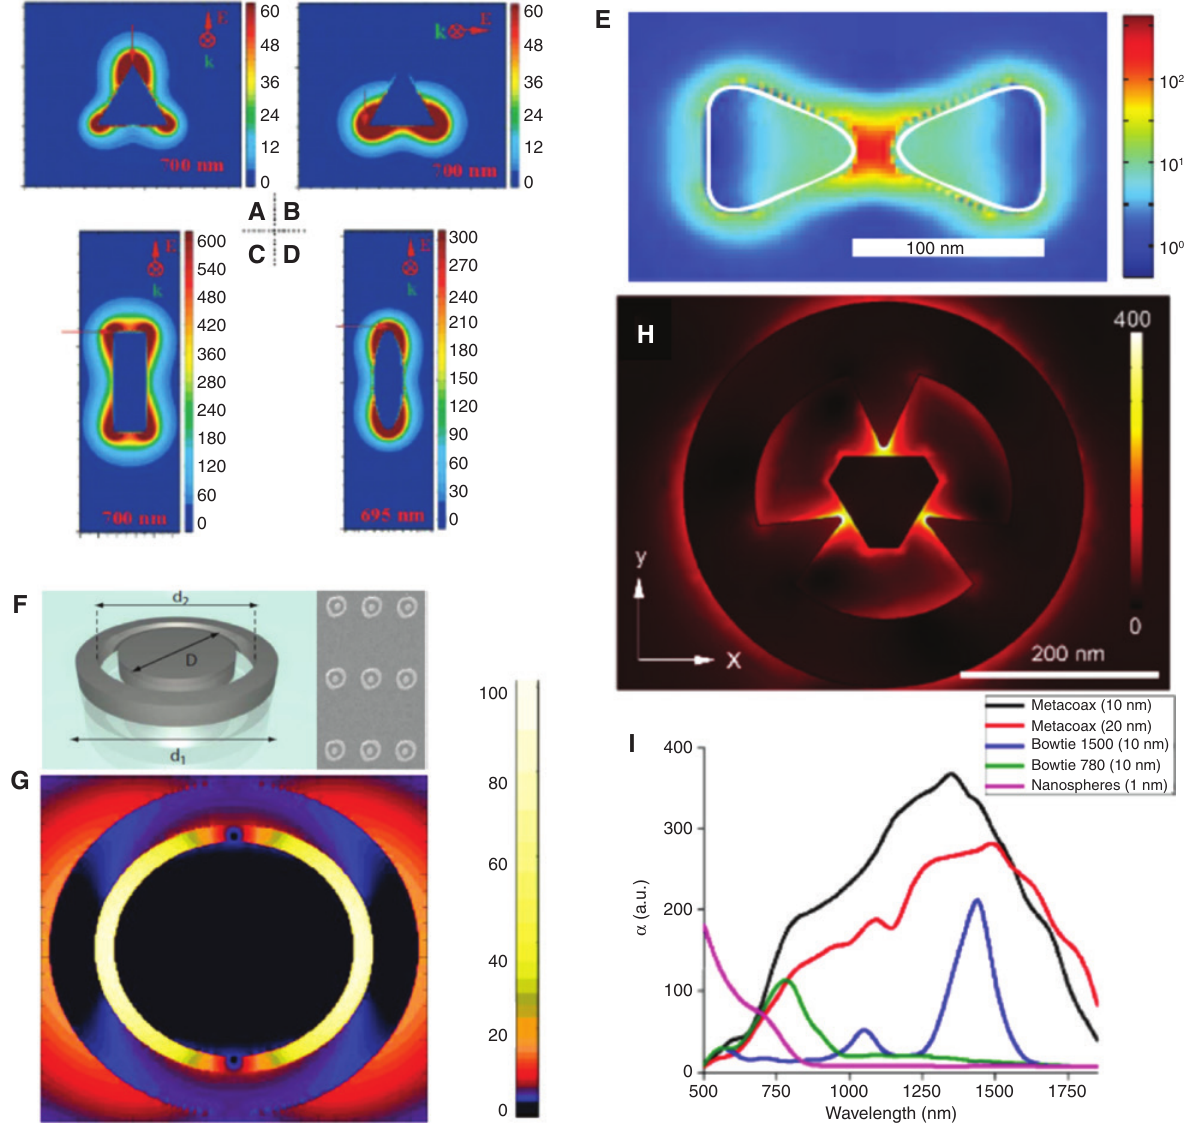
Figure 11: Selection of field intensity distribution calculations for different types of NPs and NP arrangements. (A) and (B) triangles excited at different orthogonal polarizations, (C) nanorod, (D) nanoellipsoid; (E) bowtie; (F–G) disc in ring microresonator; (H–I) coaxial nanoantenna. Figures are reproduced with permission from (A–D) [92], (E) [93], (F–G) [94], 2007, and (H–I)